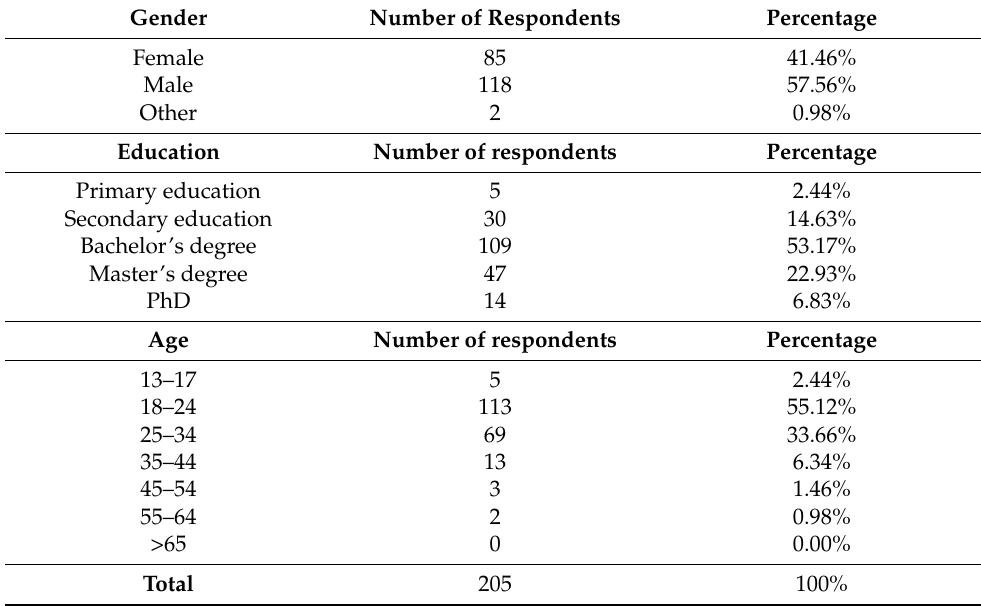
Table 1. Summary of survey